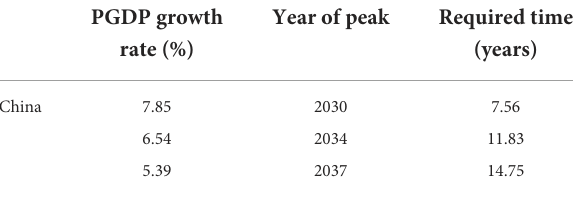
TABLE 5 Theoretical time for embodied carbon emissions in inter-regional trade to reach the